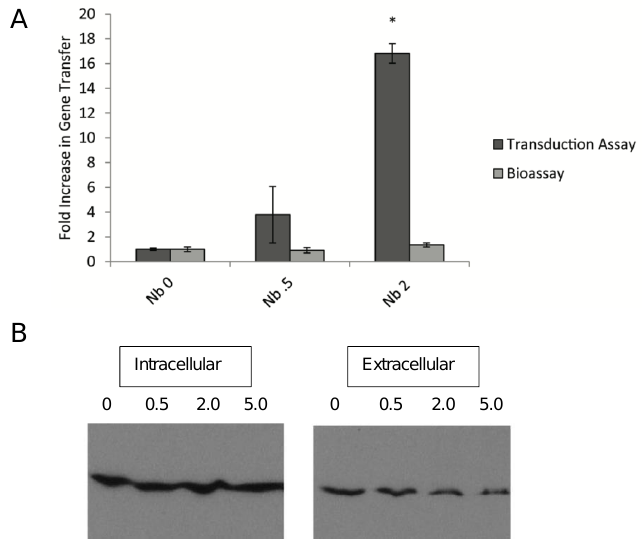
Figure 3. Comparison of gene transfer in a transduction assay and bioassay, and RcGTA levels, in response to the presence of Nb. ( A ) Transduction assay cultures (mixture of strains DW5 and ∆RC6) were grown in duplicate and used for transduction assays as well as for supernatant donors in bio- assays. The numbers below the graph give the concentration of Nb in ug/mL in the cultures. * p < 0.05 compared to cultures grown without antibiotic. Error bars show the range. ( B ) Cells (intracel- lular) and cell-free supernatants (extracellular) from transduction assay cultures were examined by Western blot, probed with RcGTA capsid antiserum. The numbers above each lane give the concen- tration of Nb in ug/mL in the cultures.